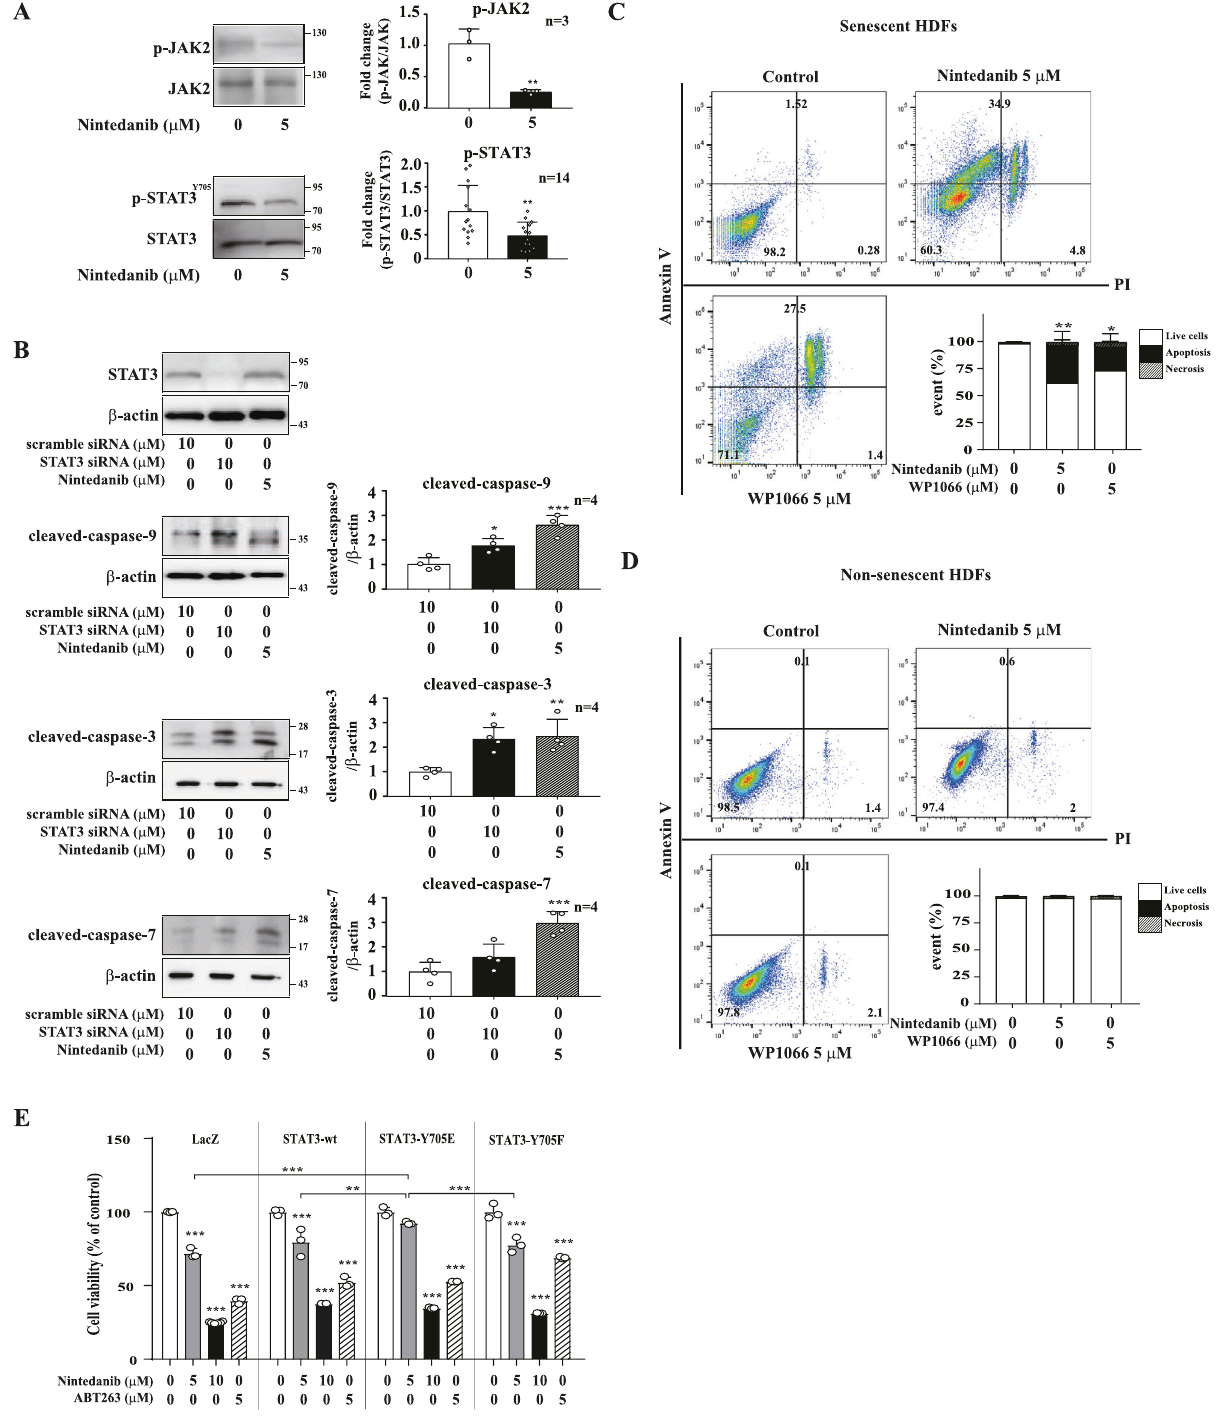
Fig. 4 Nintedanib inhibits tyrosine phosphorylation of JAK2 and STAT3 in senescent HDFs. A Senescent (S) HDFs were treated with DMSO or nintedanib (5 μ M) for one hour, and then western blot assays using anti-p-JAK2, anti-JAK2, anti-p-STAT3, and anti-STAT3 antibodies were performed to identify the signaling pathways affected by nintedanib. B Senescent (S) HDFs were transfected with scramble siRNA or STAT3- speci fi c siRNA three days prior to nintedanib (5 μ M) treatment. Then, after drug exposure for three days, western blot assays using anti-STAT3, anti-caspase-9, anti-caspase-3, and anti-caspase-7 antibodies were performed to evaluate apoptosis induction. C Senescent (S) HDFs were treated with DMSO, nintedanib (5 μ M), or WP1066 (5 μ M, a STAT3 kinase inhibitor) for three days, and a fl ow cytometry analysis with Annexin V/PI staining was performed to identify apoptotic cells. D Nonsenescent (NS) HDFs were treated with DMSO, nintedanib (5 μ M), or WP1066 (5 μ M, STAT3 kinase inhibitor) for three days, and fl ow cytometry analysis with Annexin V/PI staining was performed to identify apoptotic cells. E Nonsenescent HDFs were infected with lentiviral particles having LacZ (as control), STAT3-wt, STAT3-Y705E, or STAT3-Y705F encoded gene and then CCK-8 assays were performed after nintedanib treatment for 3 days to assess cell viability. n = 3. The data normalized to those for DMSO-treated cells are shown as the mean ± S.D. *p < 0.05, ** p < 0.01, *** p < 0.001 by one-way ANOVA with Tukey ’ s post hoc